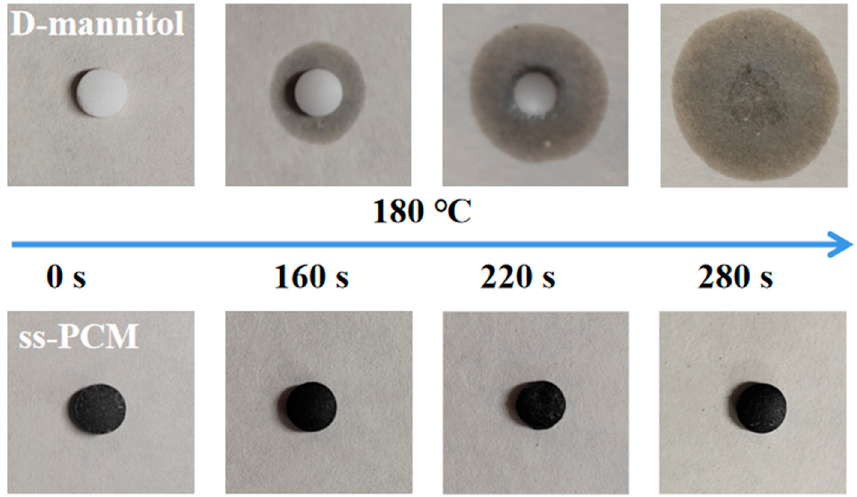
Figure 9. The optical images of the pure D-mannitol and the YC/D-mannitol ss-PCM on a heating stage.